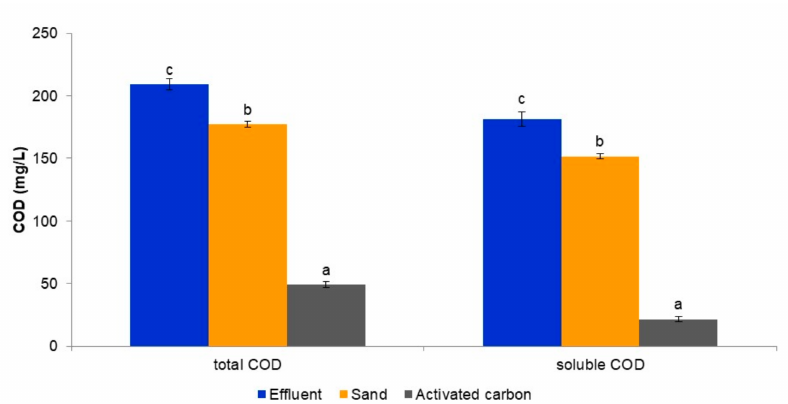
Figure 2. Total and soluble COD concentrations during processing of the biologically treated fungicide-containing effluent through the sand filter and the activated carbon adsorption column system. For each measured parameter, bars designated by the same letter are not significantly different at the 5%